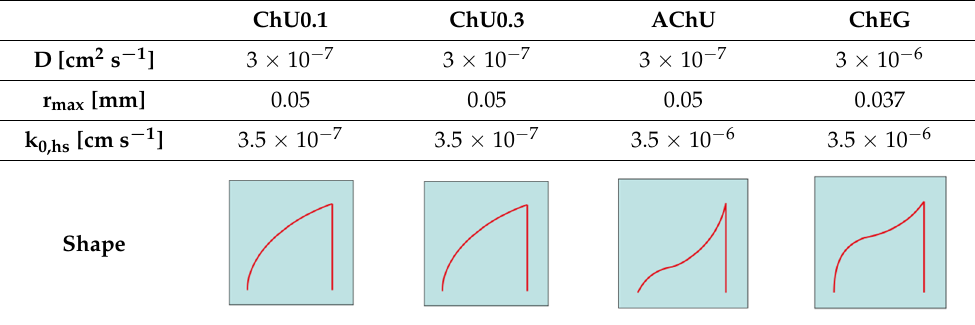
Table 2. Summary table of parameters that describe anodic–cathodic switching regime in galvanostatic cycling experiments with symmetric coin cells.